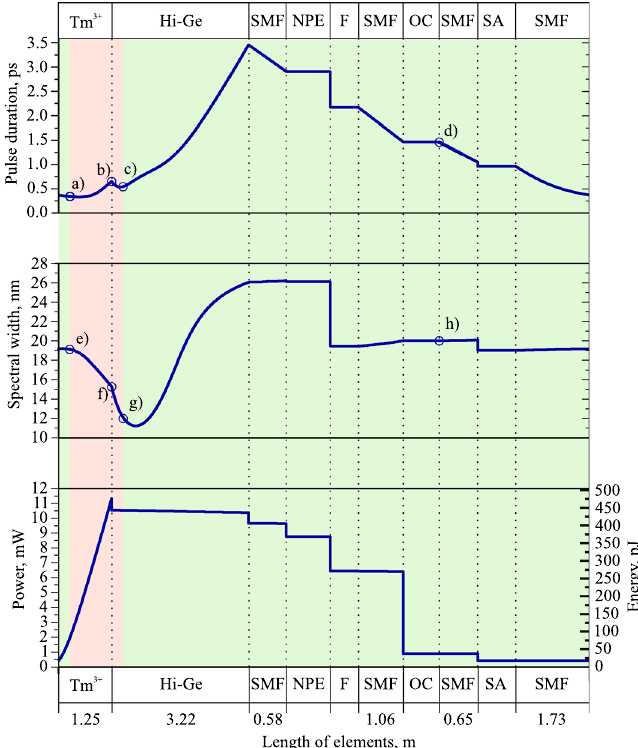
Figure 5. The intracavity pulse performance based on numerical simulations.